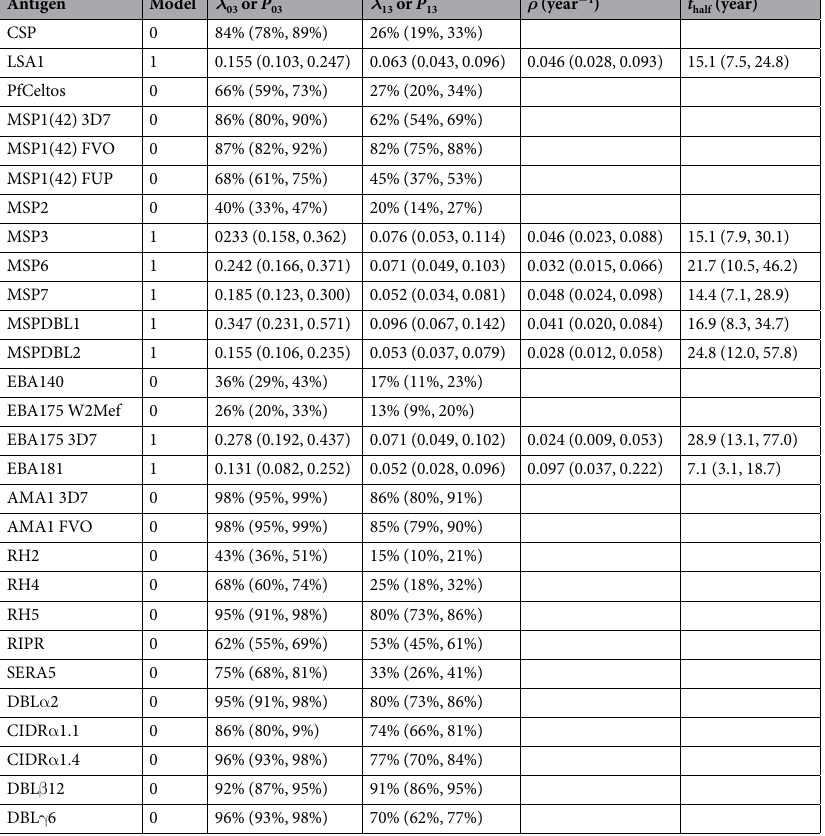
Table 1. Sero-catalytic model parameters. Results shown are the median and 95% credible intervals from the posterior parameter distribution estimated using Bayesian Markov Chain Monte Carlo (MCMC) methods. All parameters were assumed to have improper uniform priors. Of the three models tested, the best fit was selected using the Deviance Information Criterion (DIC). In the case where Model 0 was the best fit, the proportion seropositive P i is presented. In the case where Model 1 was the best fit, the seroconversion rate λ i is presented. Model 2 was not selected as the best fit for any of the antigens. Annual seroreversion rate is indicated by the symbol ρ and t half (year) indicates the half-life of sero-reversion: the time taken for 50% of a population of sero- positive individuals to revert to being sero-negative in the absence of ongoing